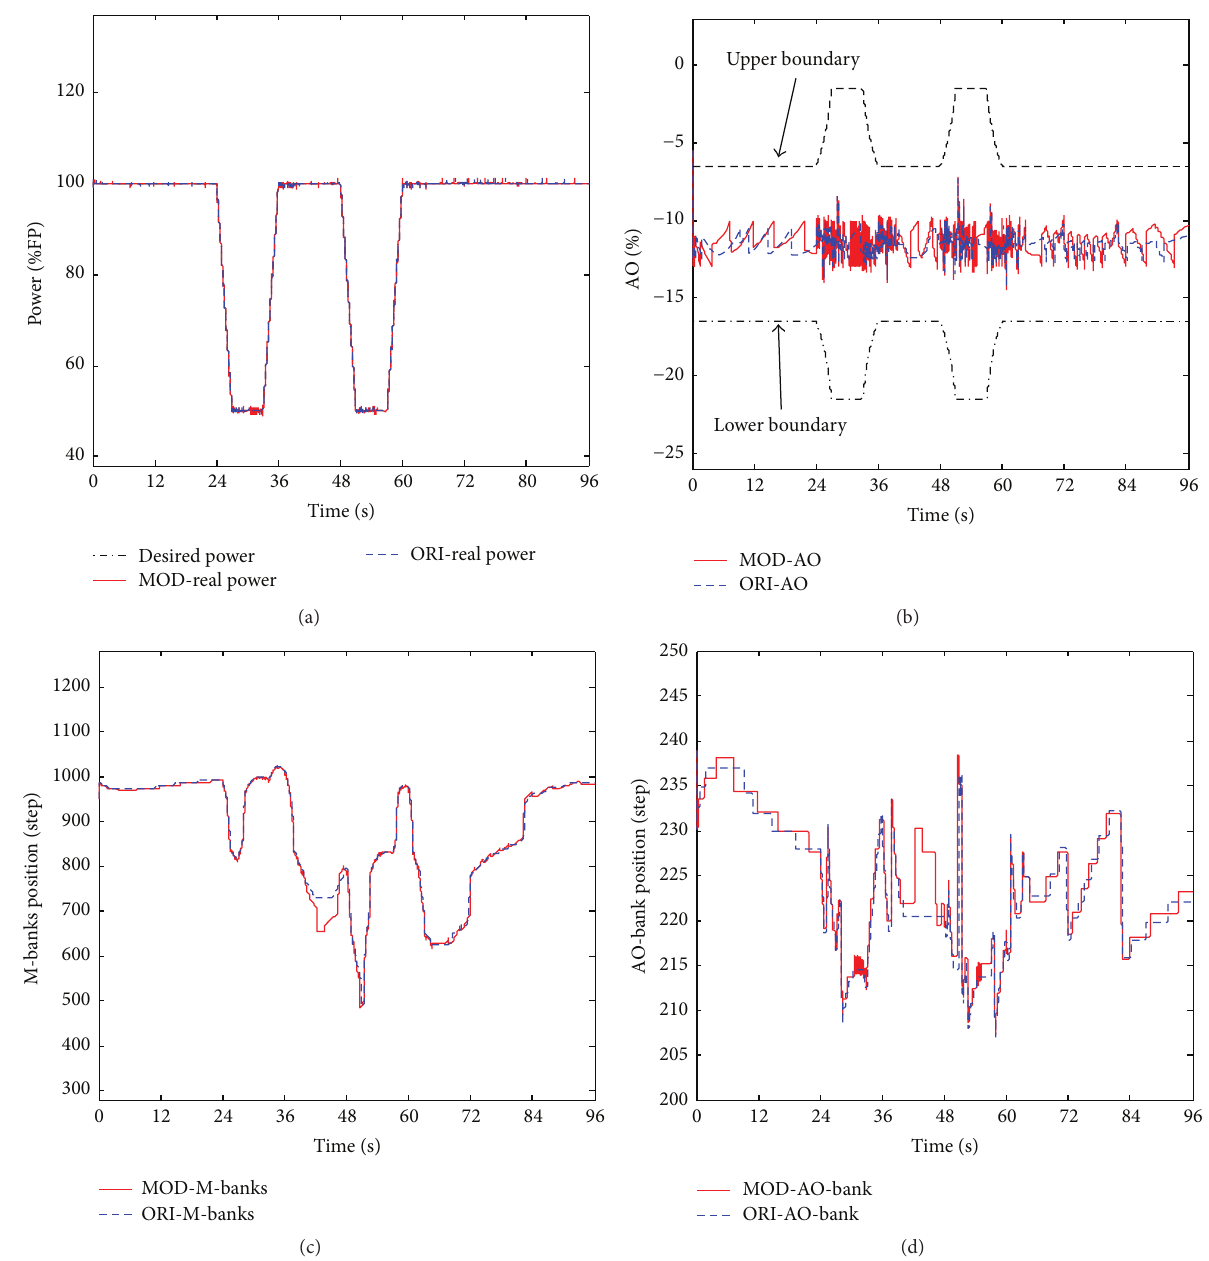
Figure 11: The load follow simulation results obtained with the improved MSHIM control strategy: (a) desired and real nuclear powers (%FP), (b) AO (%), (c) M-bank position (Step), and (d) AO-bank position